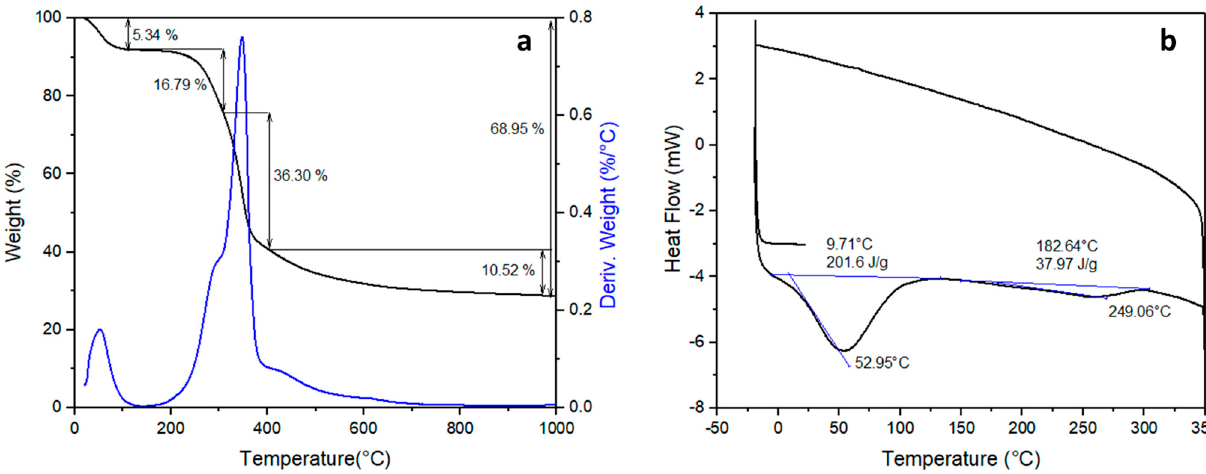
Figure 5. TGA and DTG curves ( a ) and calorimetric profile ( b ) for rice husk (exo up). Table 4. Mass of reactants and products in the reactor and biochar yield (input and output data).